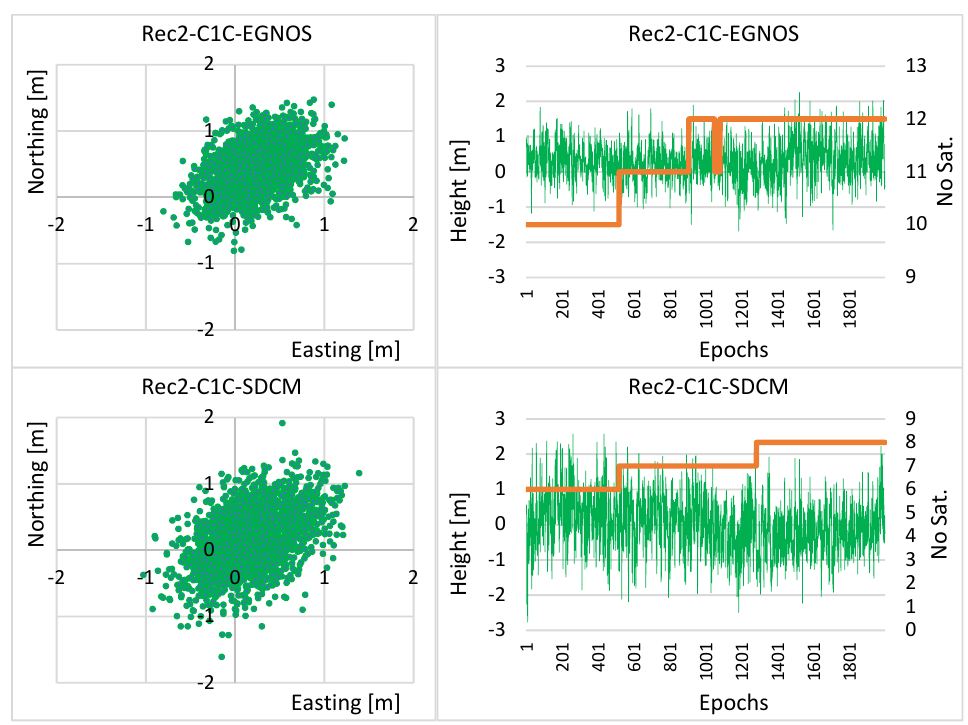
Figure 5. Real errors of horizontal and vertical coordinates of SBAS positioning based on C1C code, for the receiver Rec1 with EGNOS or SDCM corrections (Step II, see Figure 1).